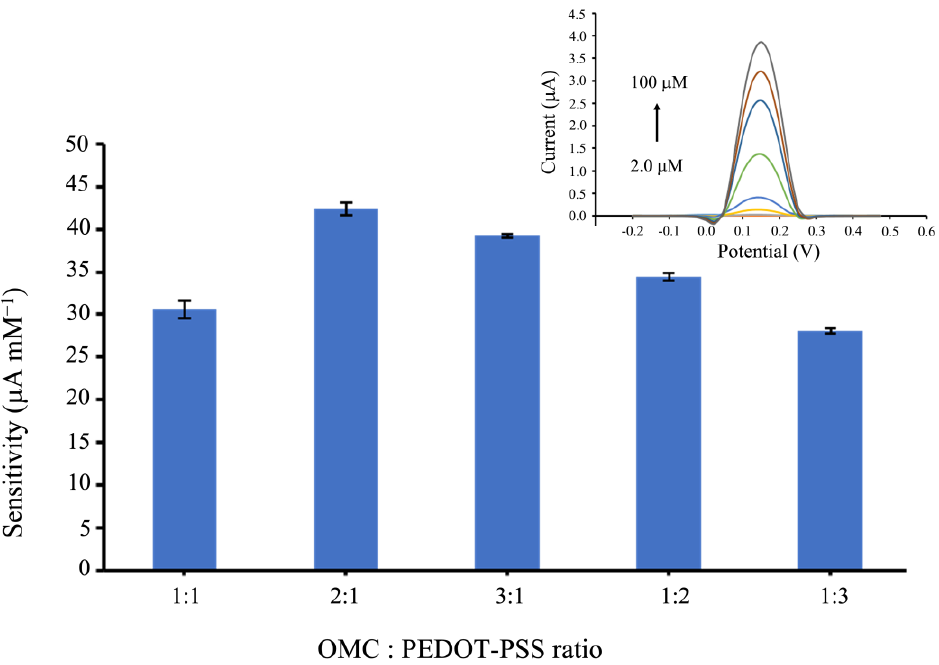
Figure 4. Effect on the sensitivity of the developed sensors to DA detection in the different ratios of OMC and PEDOT - PSS . These sensitivities were obtained by performing DPV in the series of DA concentrations at: 2.0, 5.0, 10, 20, 40, 60, 80, and 100 μ mol L −1 in 0.10 mol L −1 PBS solution (pH 7.4). The inset showed the differential pulse voltammograms of the OMC and PEDOT-PSS at 2:1 ratio when varying from 2.0 to 100 μ mol L −1 DA.